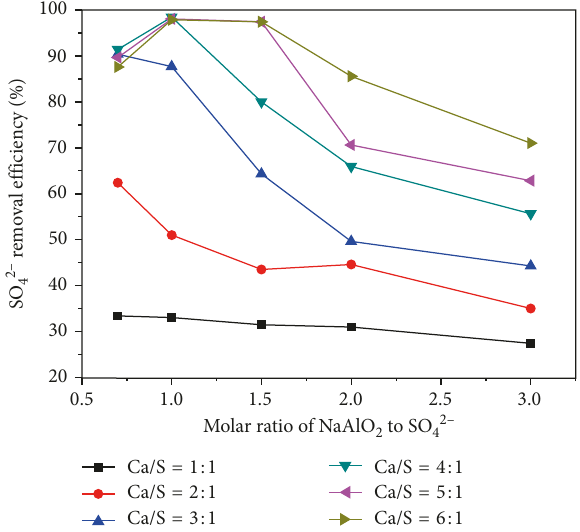
° C, Figure 2: The effect of Ca(OH) v 200r/min, t (cid:27)